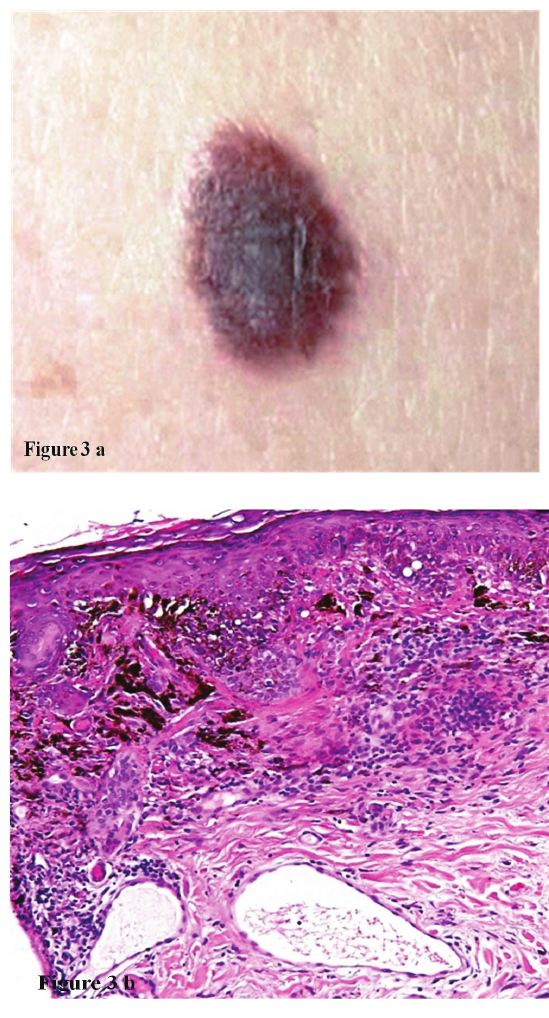
Figure 3: Atypical/dysplastic nevus on the trunk with irregular borders and variegated color distribution. Figure 3b at 40 x: Atypical/dysplastic melanocytic nevus exhibiting architectural asymmetry, vague borders and irregular pigmentation of dermal nevus cells. Nevus cells show nuclear hyperchromasia, and dusty melanin are spindled and parallel to the surface. Note the bridging of irregular and adjacent rete ridges and vascular